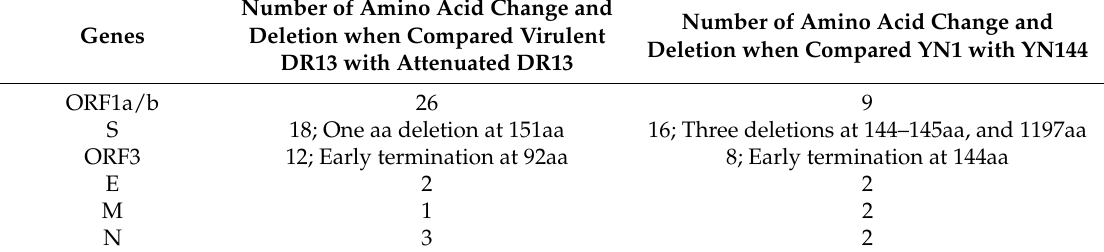
Table 3. Comparison of the variation in genome of classical and variant virulent/attenuated strains.